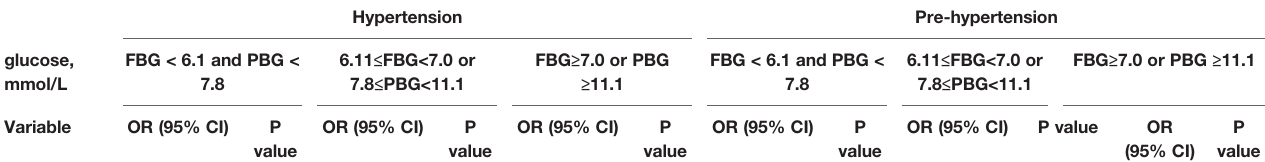
TABLE 4 | Association of CVAI, VAI, BMI, WC, WHtR, WHR and LDL-C with hypertension and prehypertension by blood glucose. Hypertension Pre-hypertension glucose,